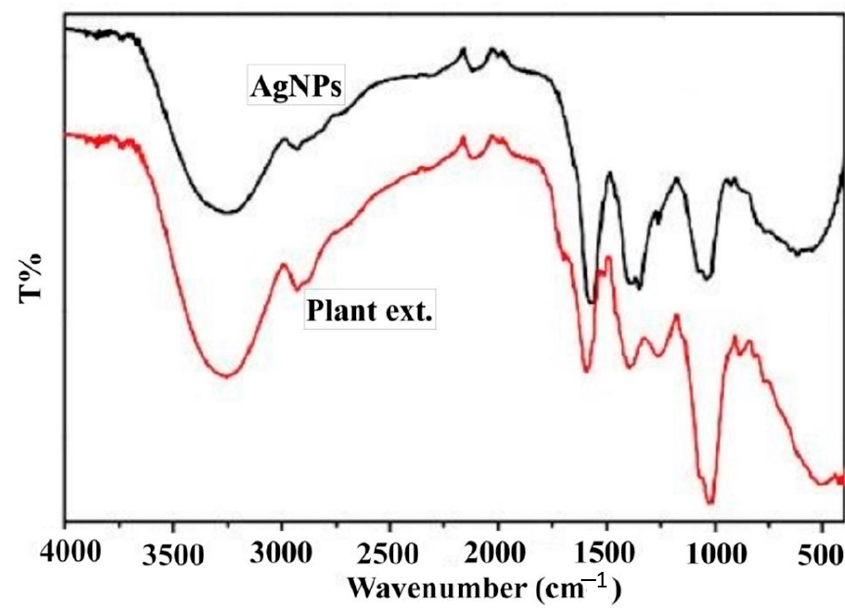
Figure 2. FTIR spectrum of biosynthesized Ag nanoparticles.